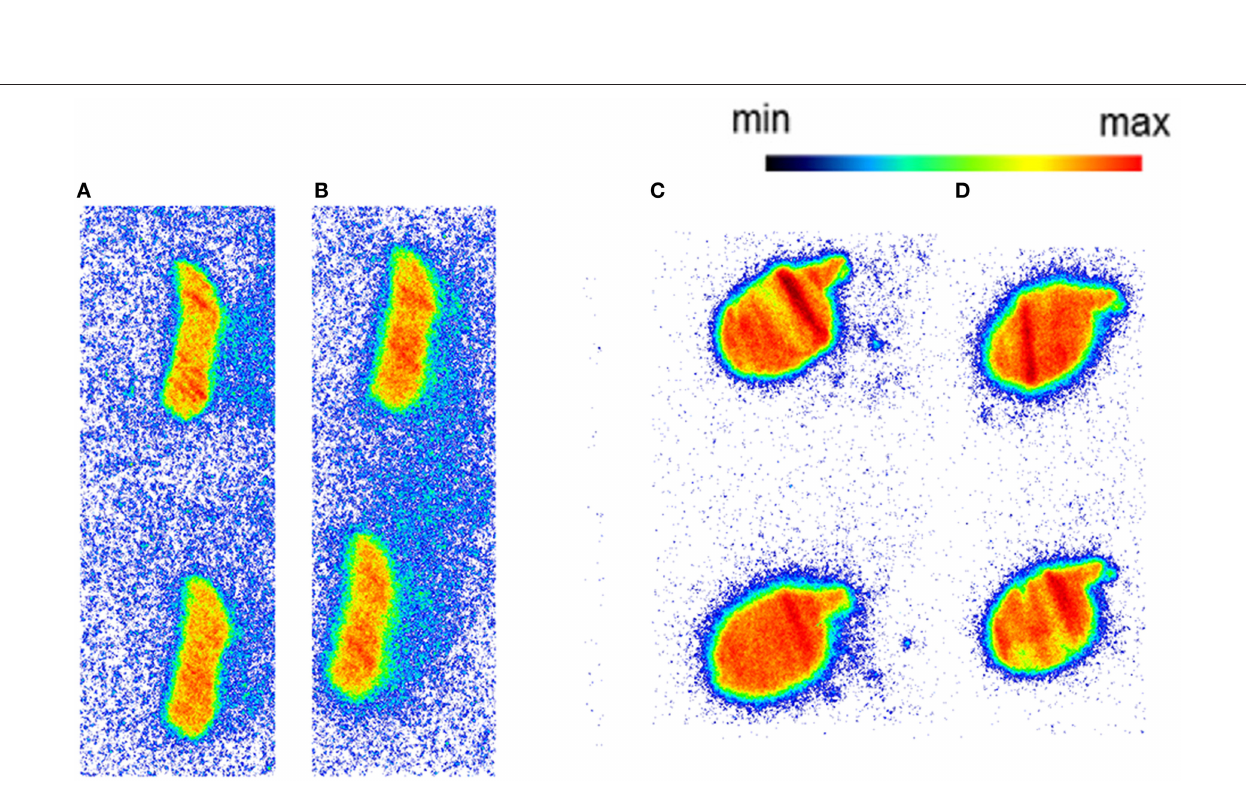
FIGURE 4 | The autoradiography results obtained with 5 nM [ 11 C]AAT-015 using spleen tissue sections. (A) Mouse spleen under baseline condition; (B) Mouse spleen under blockade conditions (10 µ M GW405833); (C) Rat spleen under baseline conditions; (D) Rat spleen under blockade conditions (10 µ M GW405833); n =